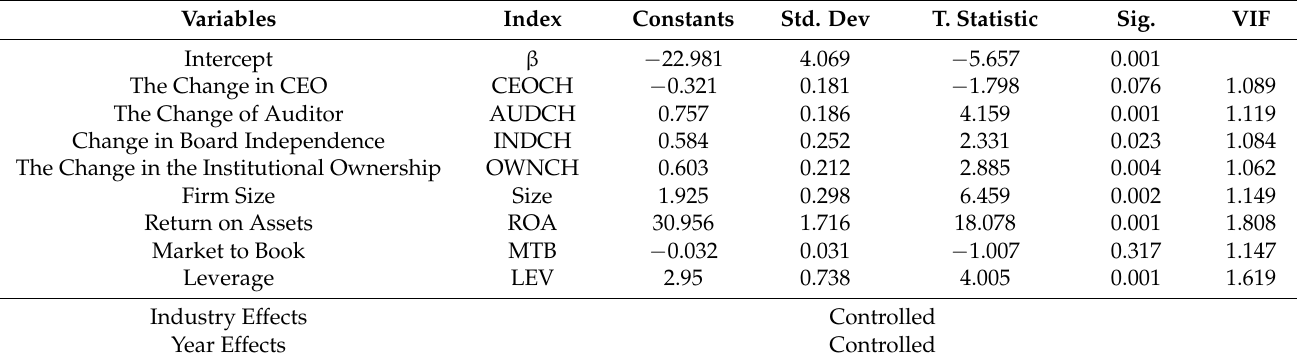
Table 4. The results of the third hypothesis